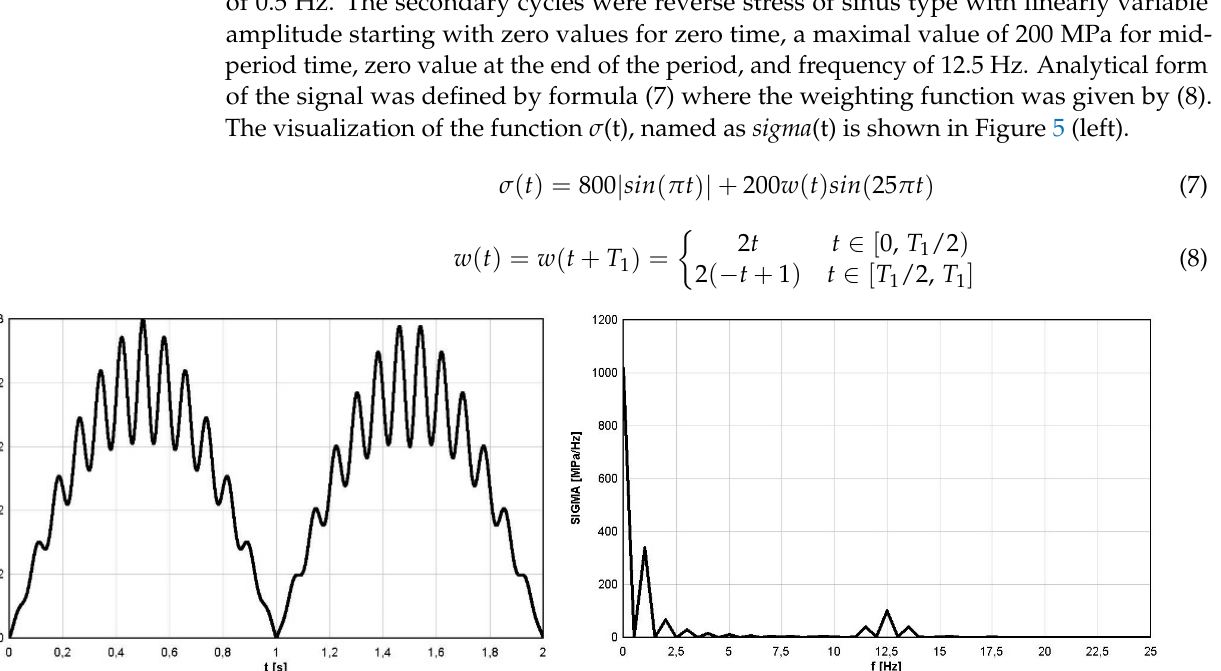
Figure 6. STFT form of the function (9).